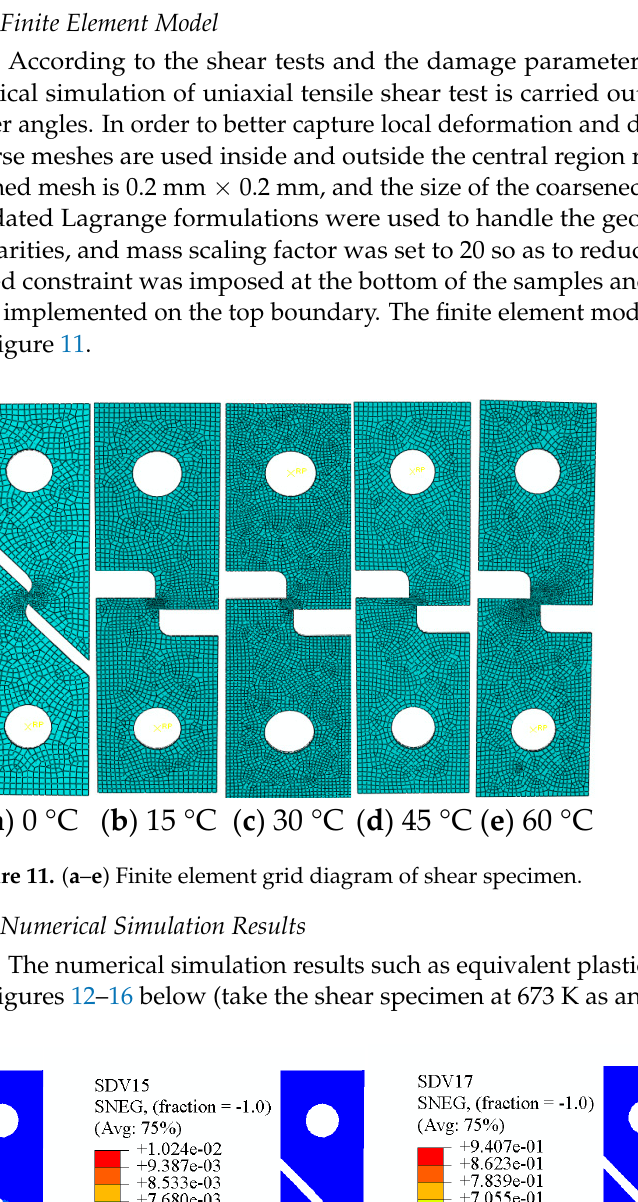
Figure 13. Equivalent plastic strain, VVF, shear damage at the beginning of microcrack in 15° spec- imen, and the result diagram of the specimen.